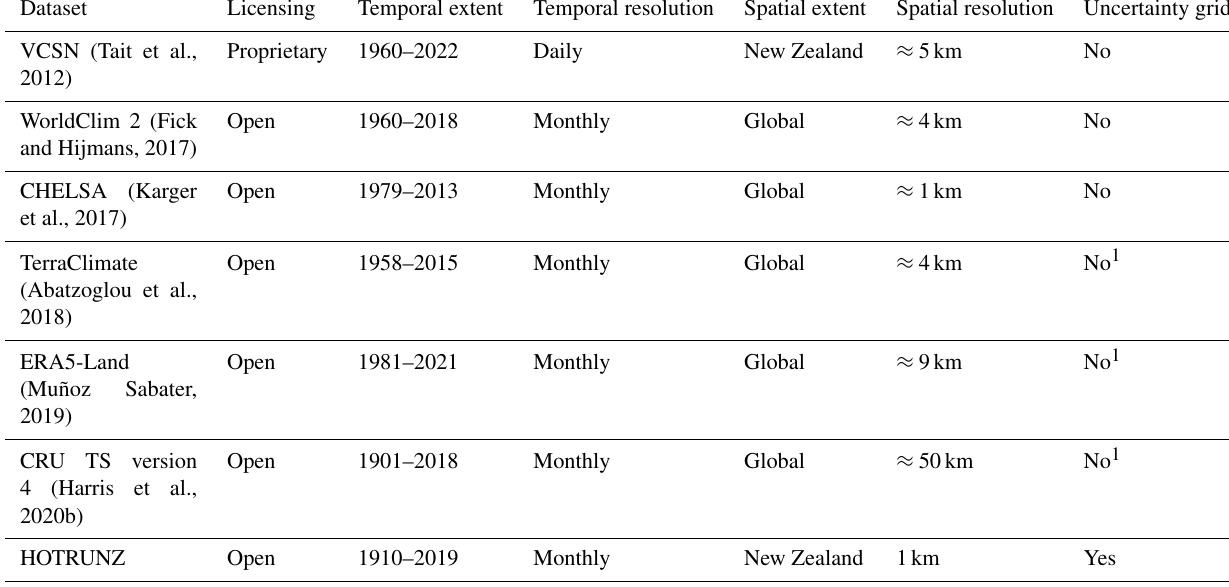
Table 1. Datasets providing a time series of spatial grids that estimate rainfall and temperature that include New Zealand.